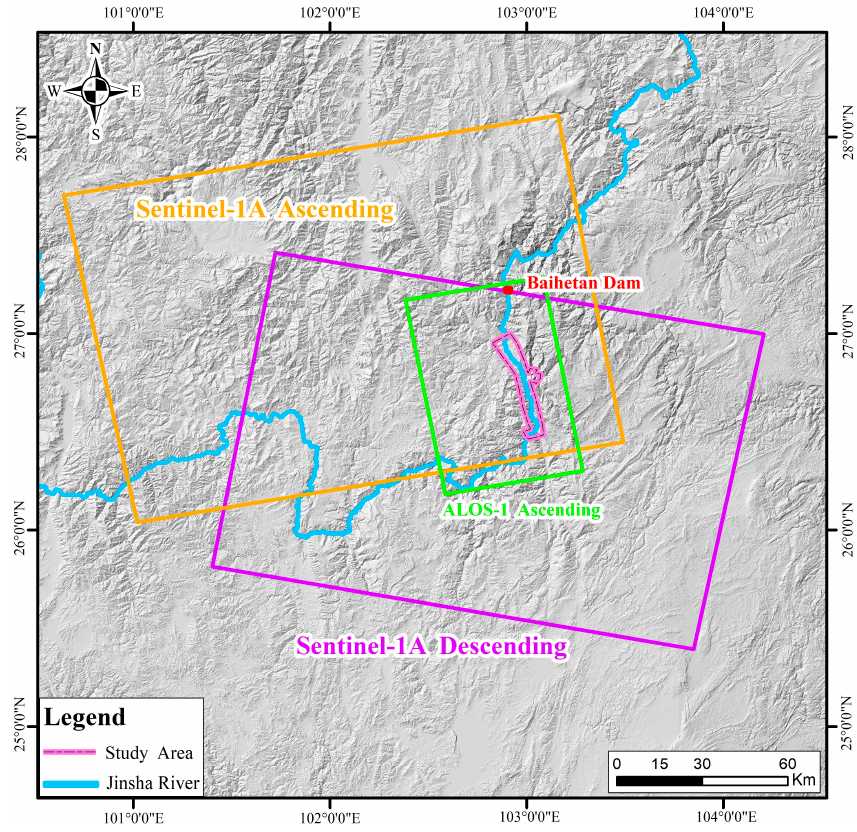
Figure 3. SAR data coverage in the study area. Table 1. Basic parameters of SAR data in the study area.